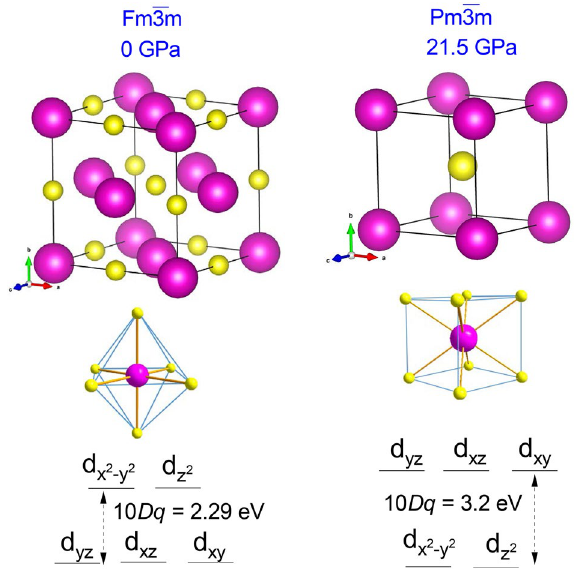
Figure 2. Unit cell and Eu 2 + –S coordination in the B1 (left) and B2 phase (right). Pink and yellow balls represent Eu 2 + and S 2 − ions, respectively. The respective energetic positions of the 5 e g and the 5 t 2 g orbitals are schematically shown next to the structure models.